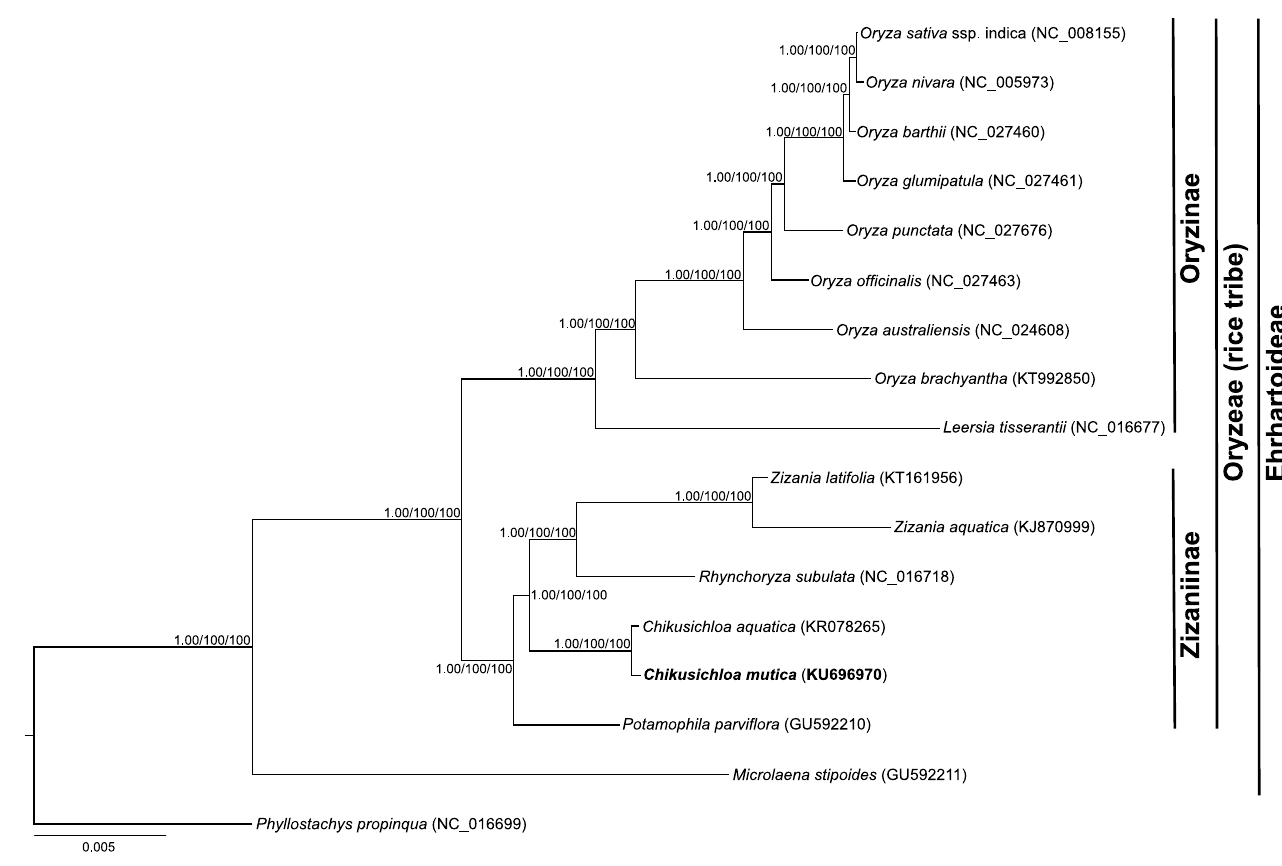
Fig 3. The chloroplast phylogenomic trees were generated from 17 grass species. Three different methods as Bayesianinference (BI), maximum parsimony (MP) and maximum likelihood(ML) were employedto build the tree. Numbersabove the branches were the posterior probabilities for BI and bootstrapvalues of MP and NL. Branch lengthis proportional to the numberof substitutions, as indicatedby the scale bar.